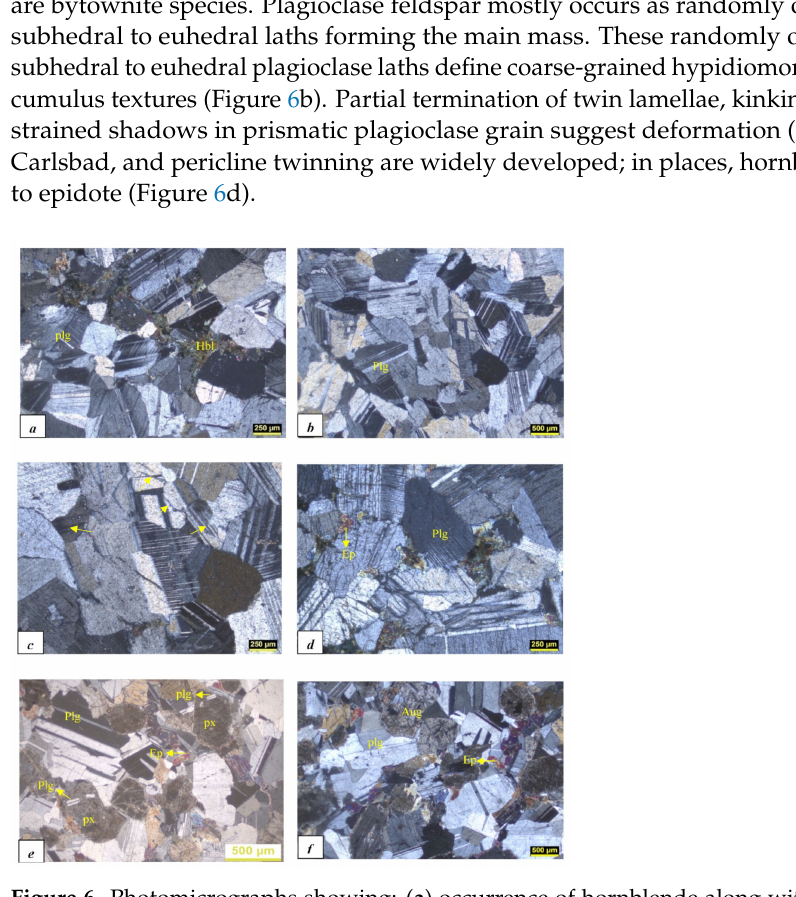
Figure 6. Photomicrographs showing: ( a ) occurrence of hornblende along with the intergranular space between plagioclase in anorthosite; ( b ) cumulus plagioclase crystals exhibited by anorthosite; ( c ) discontinuous twin lamellae and strain shadow suggesting deformation in anorthosite; ( d ) devel- opment of epidote along with the intergranular space between plagioclase in anorthosite; ( e ) typical ophitic texture in gabbro; and ( f ) cumulus textural pattern in